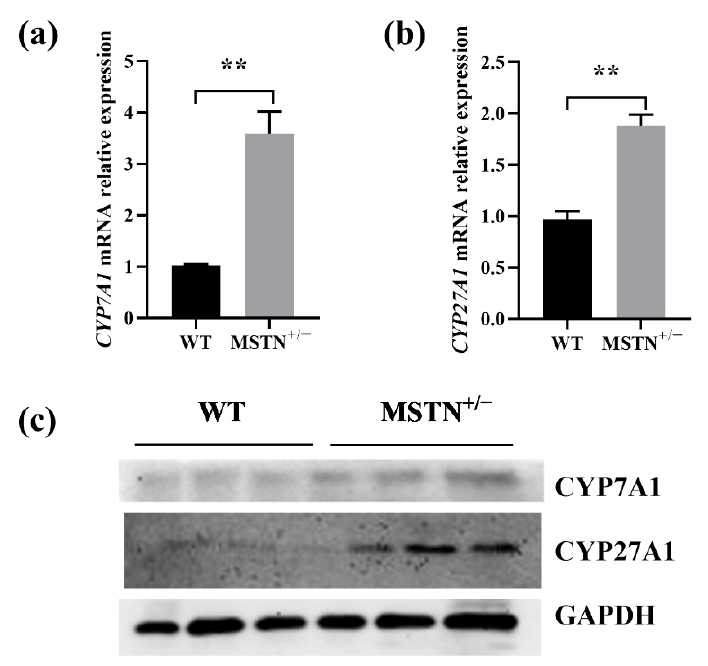
Figure 5. MSTN knockout increased expression of genes related to bile acid synthesis in the liver of MSTN +/ − and WT cattle. ( a , b ) Expression of cholesterol 7 alpha-hydroxylase (CYP7A1) and sterol 27-hydroxylase (CYP27A1) mRNA. ( c ) Expression of CYP7A1 and CYP27A1 protein. ** p < 0.01. WT, wild type; MSTN +/ − , MSTN heterozygous deletion.